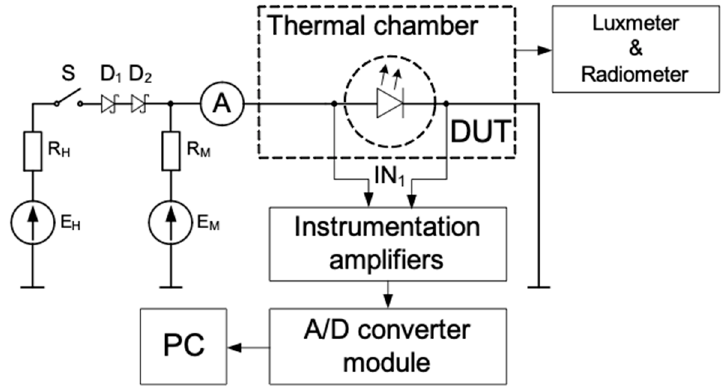
Figure 2. Measurement set-up scheme.